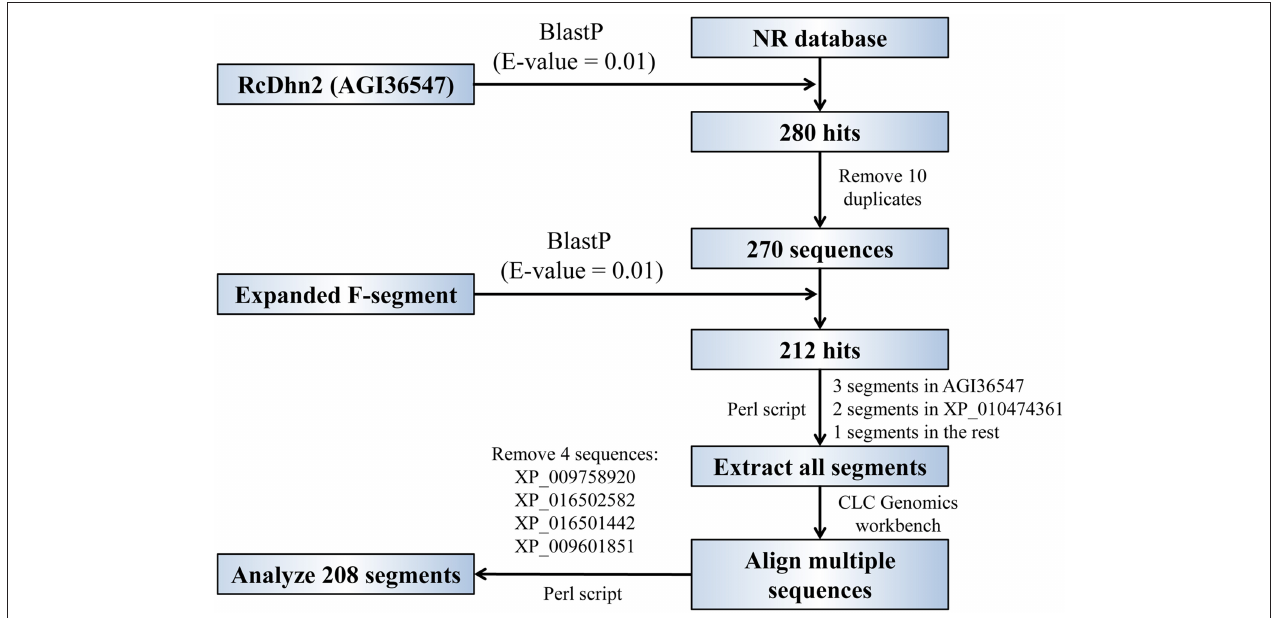
FIGURE 2 | Flowchart for global and local BlastP analyses to identify the homologous proteins that contain the conserved, expanded F-segment in protein database. See the Materials and Methods section for